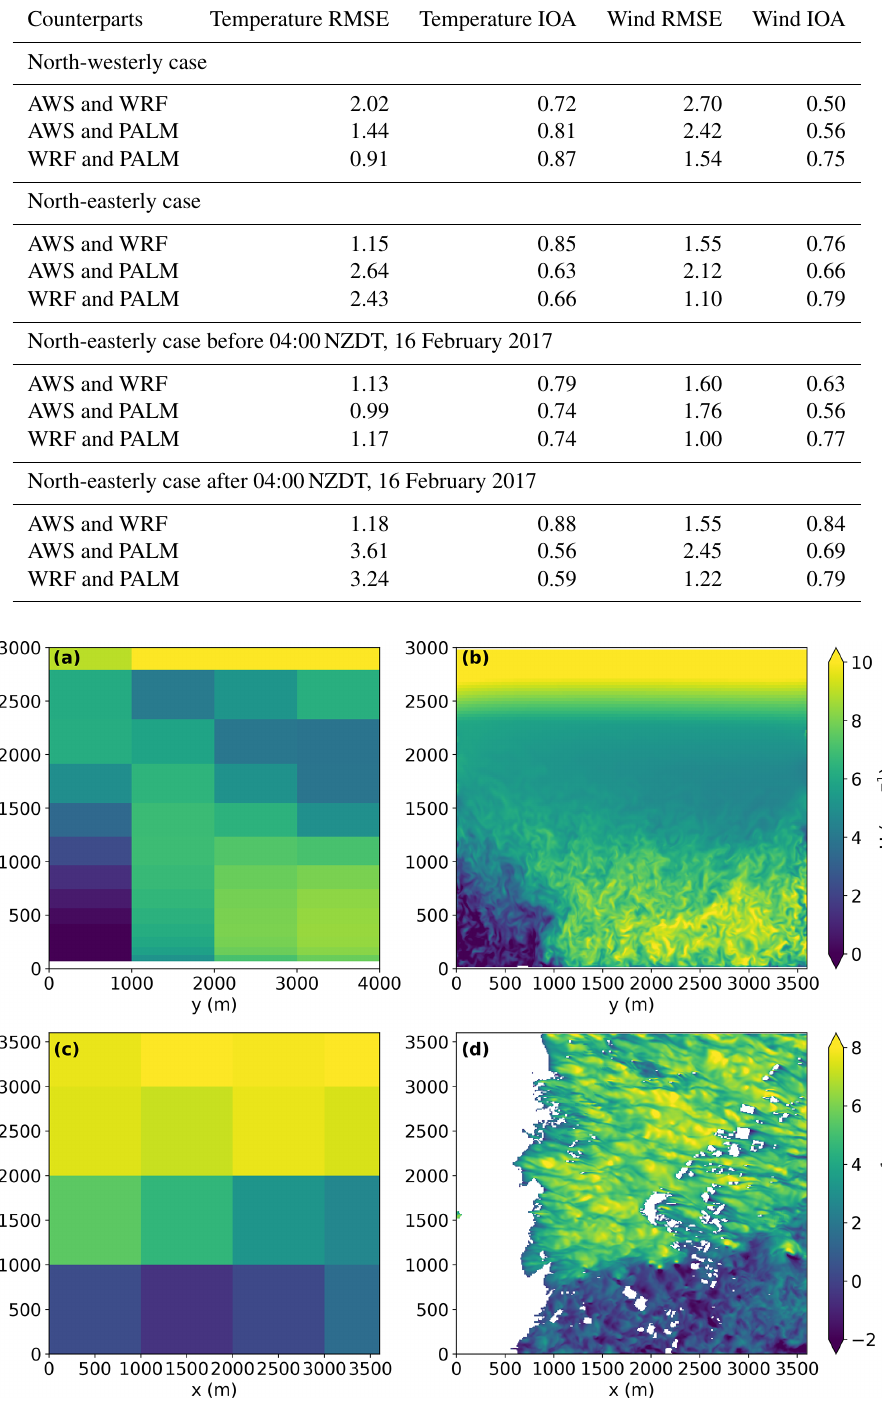
Figure 7. The north-westerly case. South–north vertical cross sections of the u component of winds taken from the WRF model (a) and PALM (b) at 14:00NZDT, 14 February 2017. Horizontal cross sections of the u component of winds taken from the lowest level in the WRF model (c) and 5m height in PALM (d) at 14:00NZDT, 14 February 2017. White areas indicate terrain and buildings higher than 5m above the lowest level in the PALM simulation